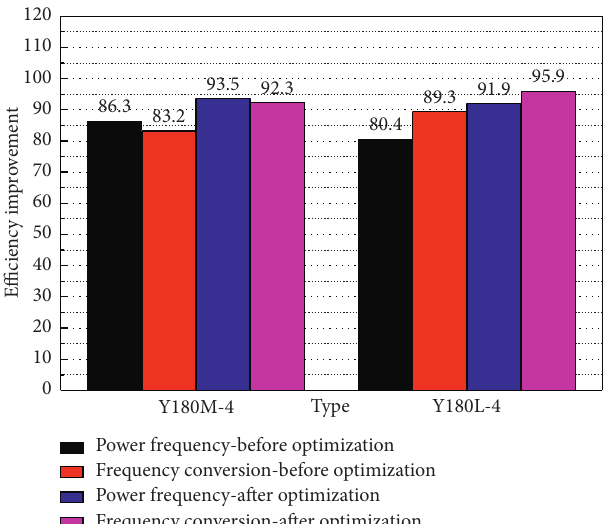
Figure 7: Comparison of efficiency before and after optimization.